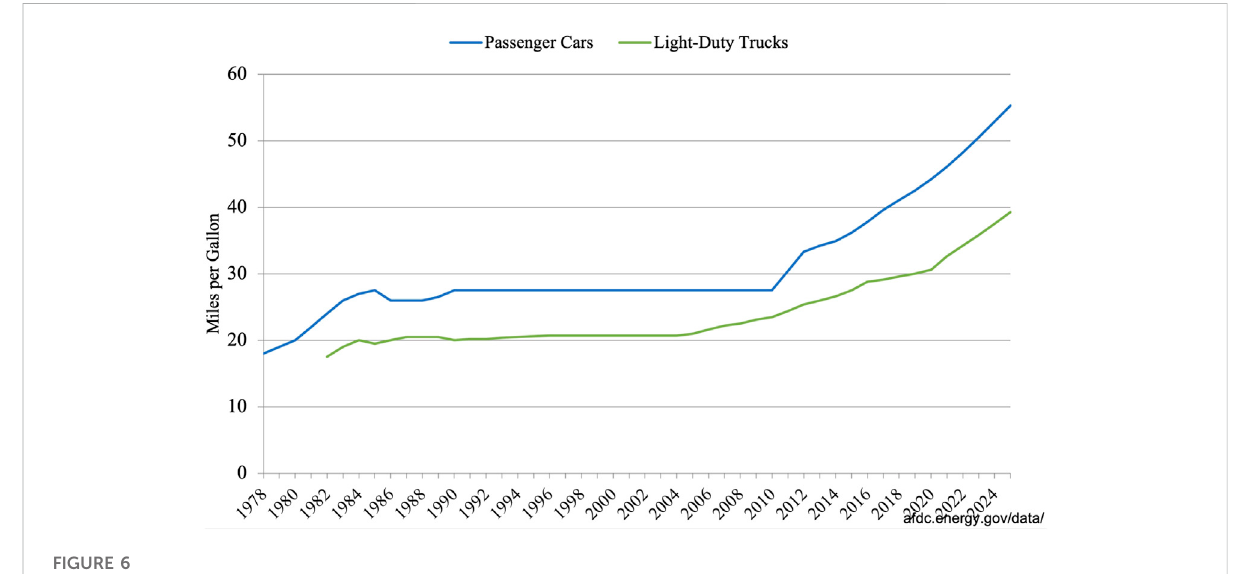
FIGURE 6 Global PEV penetration by region 2015 – 2021 (IEA,